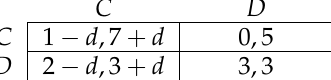
Figure 7. Prisoner’s Dilemma 2 transformed by a unilateral offer Row 3